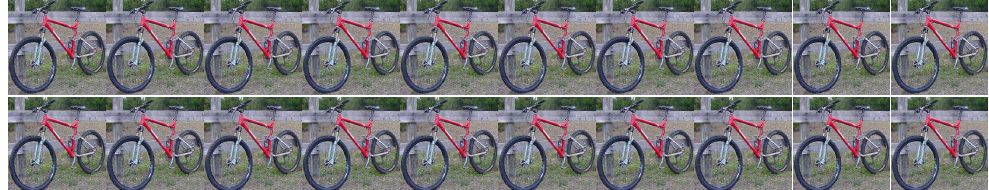
( A 8 ) stemming from the A 8 10 k